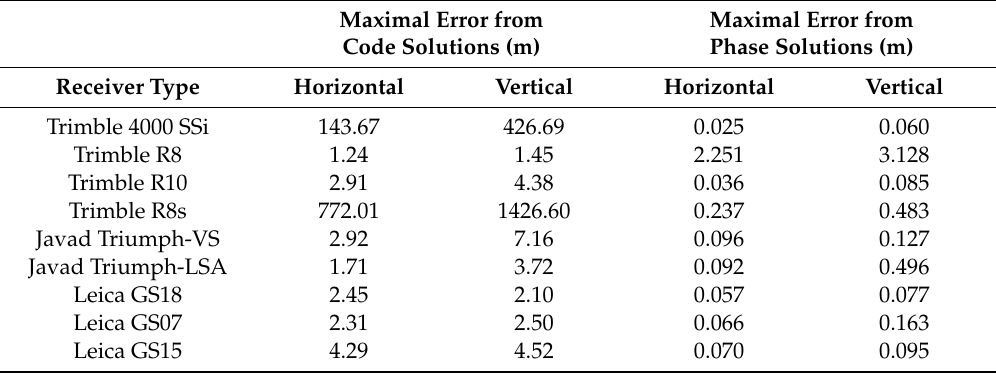
Table 6. Quality of positioning: maximal horizontal and vertical deviations in coordinates in the horizontal plane and in heights during static and kinematic